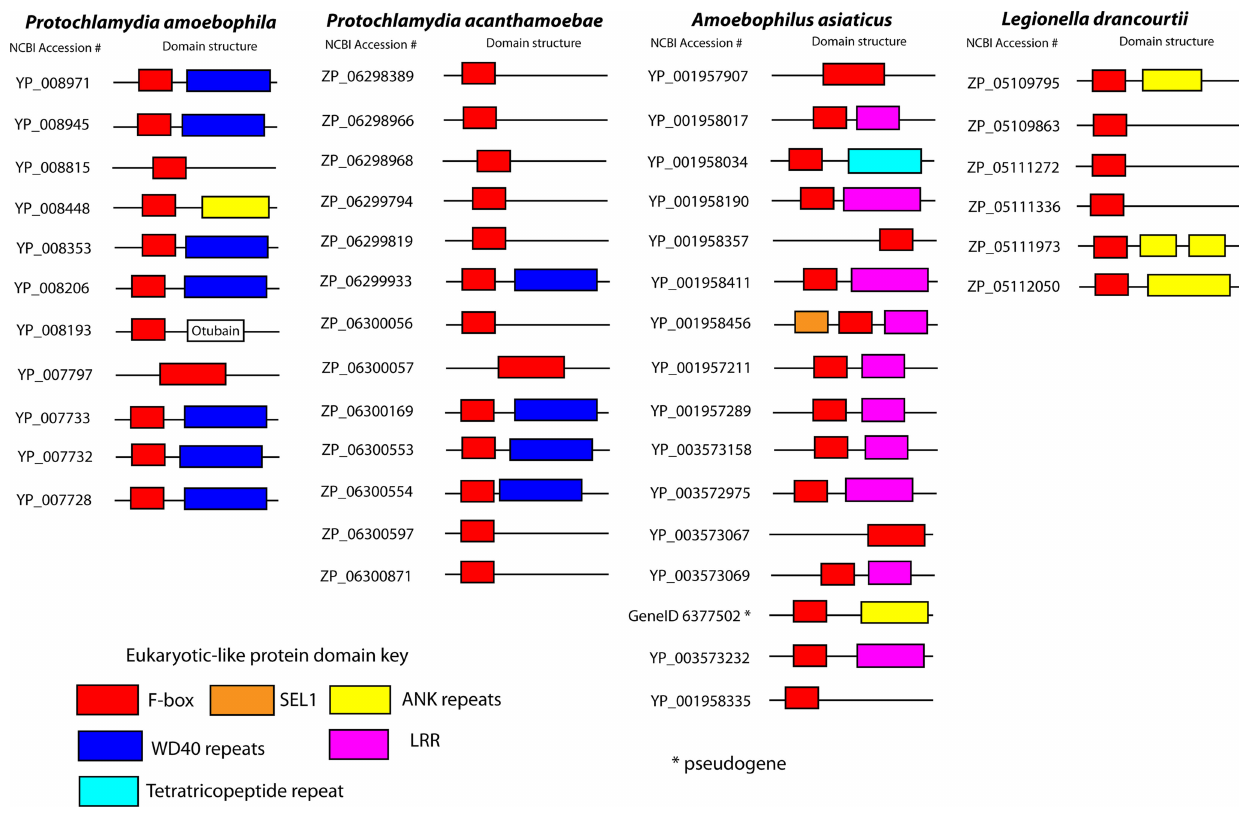
FiGure 5 | F-box proteins in amebal endosymbionts. Cartoon representations of the domain structures of bacterial F-box proteins found in amebal symbionts. Proteins and domain predictions were found at the EMBL-EBI website InterPro website (http://www.ebi.ac.uk/interpro), using the F-box domain motif IPR001810. Genes are identified by their name or NCBI accession